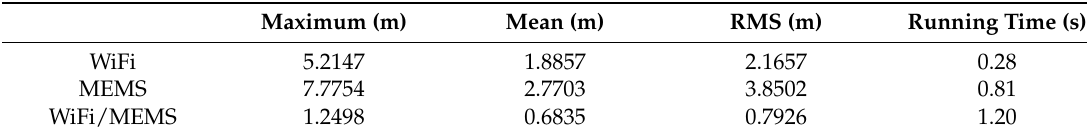
Table 4. Positioning errors and running